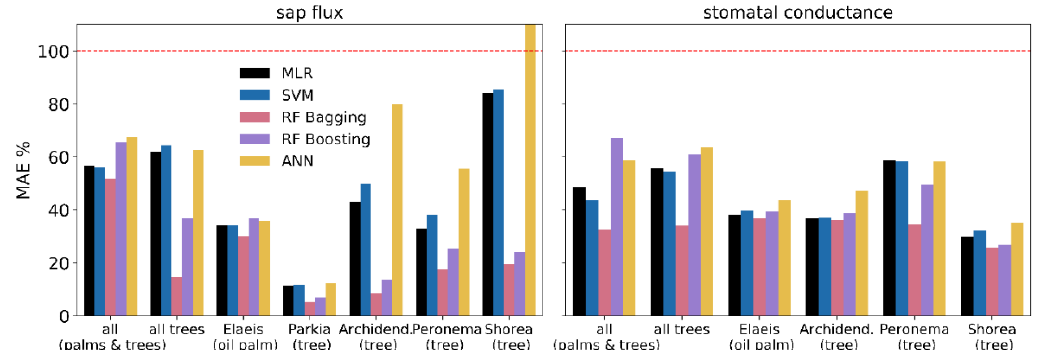
Figure 3. Mean absolute error (MAE) of predicted and measured values for sap flux and stomatal conductance.